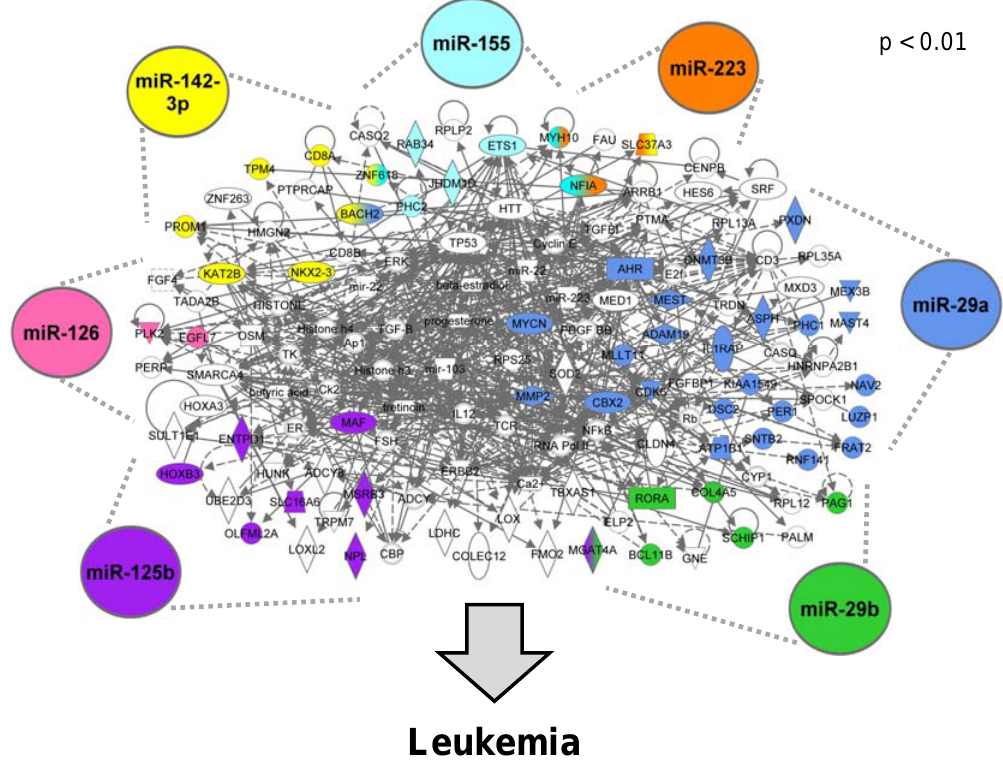
Figure 3. The AML Signalisome. Proteins encoded by genes dysregulated in AML patients are shaded in colors corresponding to their regulatory miRNA(s). White molecules are associated with the AML-associated